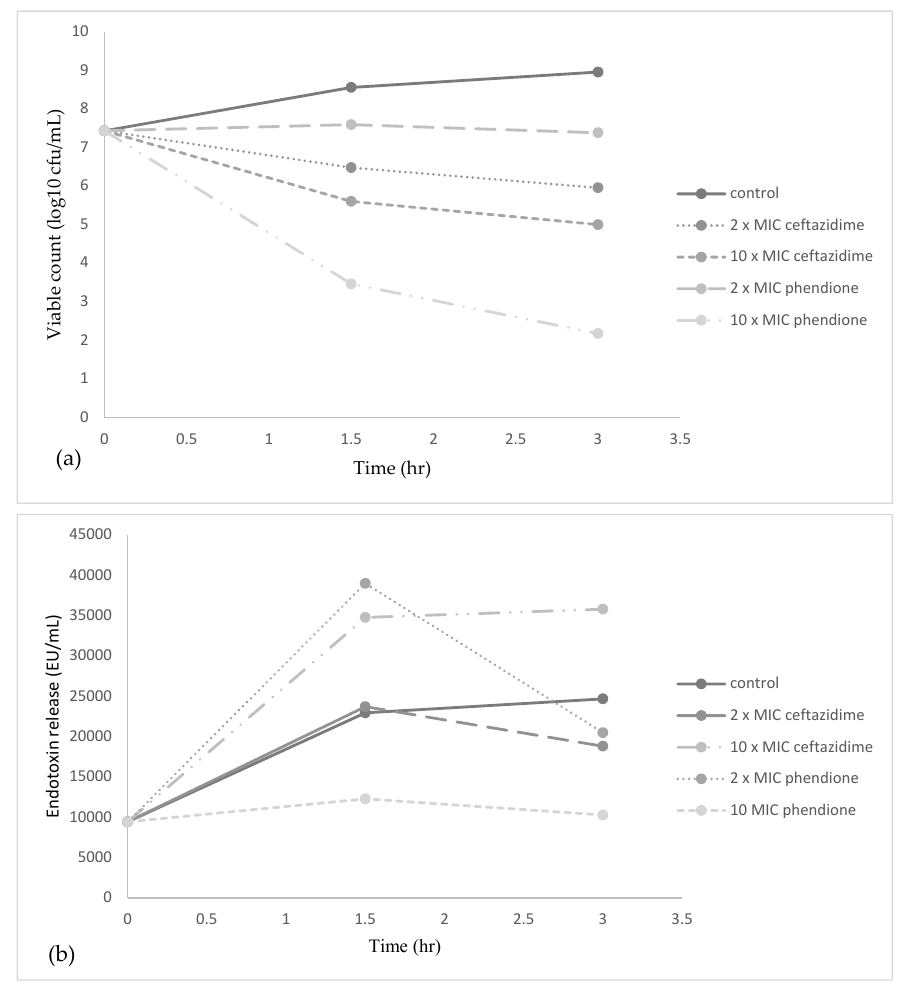
Figure 1. Effects of ceftazidime and phendione at 2 × and 10 × MIC on ( a ) growth and ( b ) release of endotoxin from ESBL E. coli , where drugs were added at time 0. Control cultures contained sterile media only. Table 4 depicts the activity of disinfectant agents, peracetic acid, triameen and BAC, where various formulations are routinely used in the health care sector. All test strains proved susceptible to all three agents at concentrations recommended by the manufac ‐ turer. Peracetic acid was the most effective test agent, providing significant zones of inhi ‐ bition that ranged from 18 to 26 mm at a concentration of 0.1% and 38 to 45 mm at 1%. The order of susceptibility among clinical isolates (from highest to lowest) was as follows: P. mirabilis (45 mm), P. aeruginosa (44.3 mm), A. baumannii (41 mm), K. pneumoniae (40 mm), E. coli (39 mm), P. fulva , and P. fluorescens (38 mm). The next most active agent was tri ‐ ameen, being most effective against P. mirabilis and P. fluorescens at all tested concentra ‐ tions, where max zones of 33 and 30 mm were achieved, respectively. For all remaining